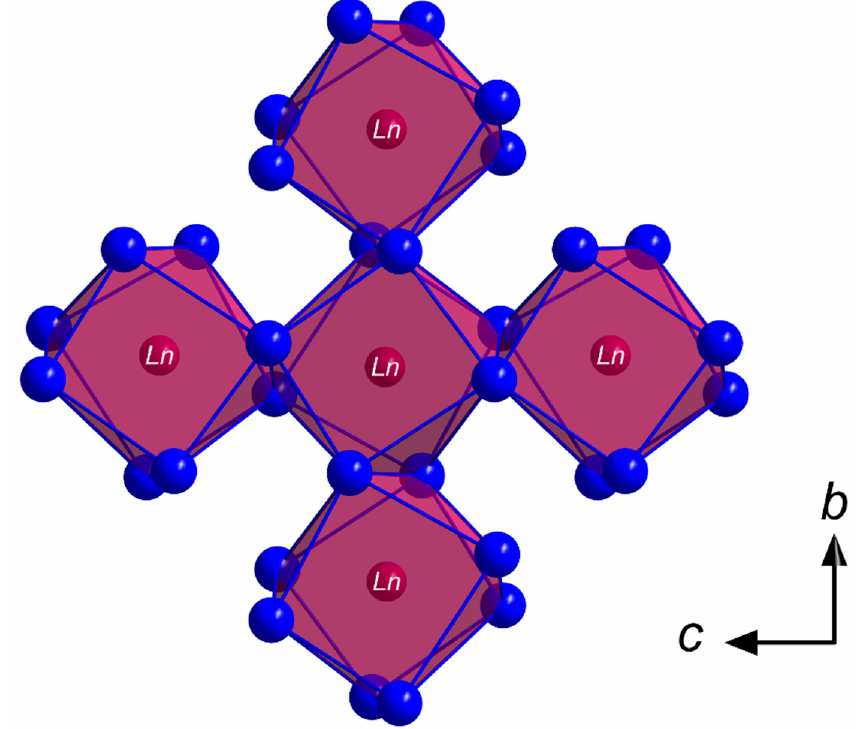
Figure 2. Infinite layer of the composition {[𝐿𝑛O (cid:2876)/(cid:2870)(cid:3032) (cid:2998)(cid:2870) ] (cid:2873)– } in the crystal structure of the Ln Sb 2 O 4 Br series ( Ln = Eu ‒ Tb) as viewed along [100] showing edge-connected [ Ln O 8 ] 13 ‒ hemiprisms spreading out parallel to the (100) plane.